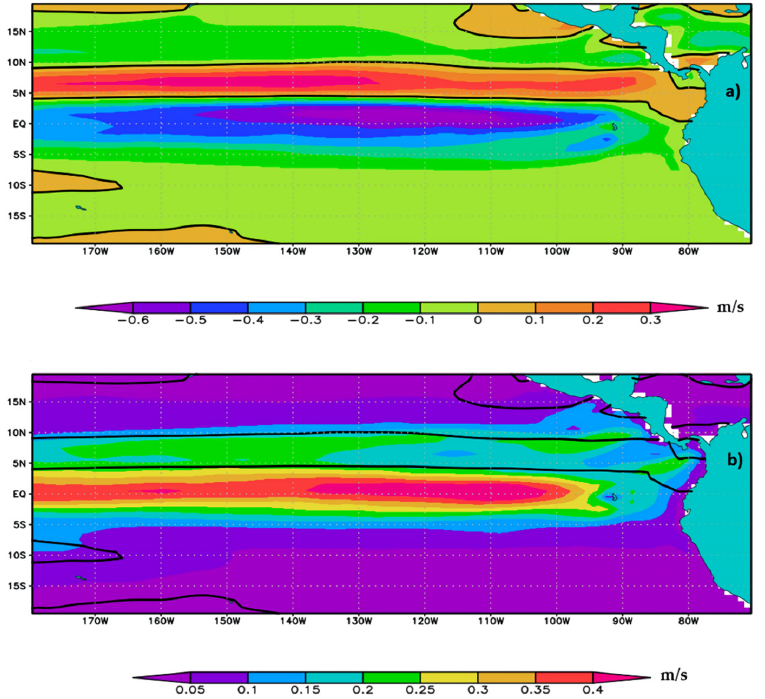
Figure 1. Mean map of ( a ) zonal velocity of ORAS4 surface current and ( b ) the corresponding standard deviation, calculated over the period of 1978 to 2017.